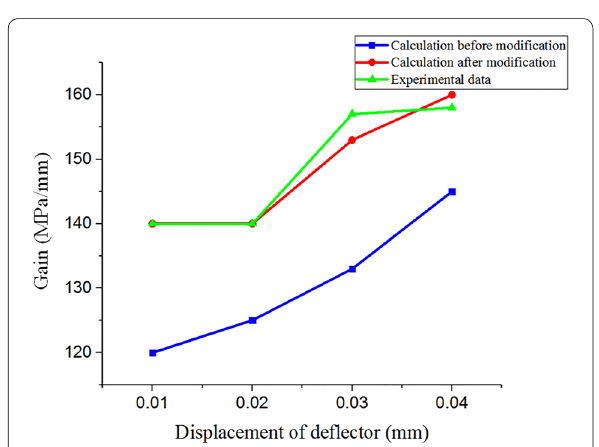
Figure 27 Comparison of the pressure